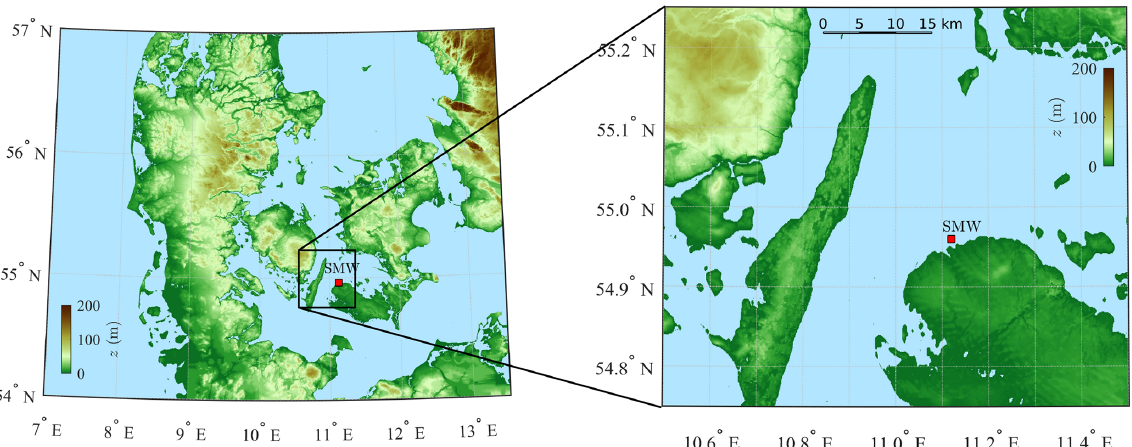
Figure 1. Digital elevation model of southern Denmark showing the location of Sea Mast West (SMW), in a sheltered flat coastal environ- ment. Only the wind from 220 to 330 ◦ is considered for SMW.